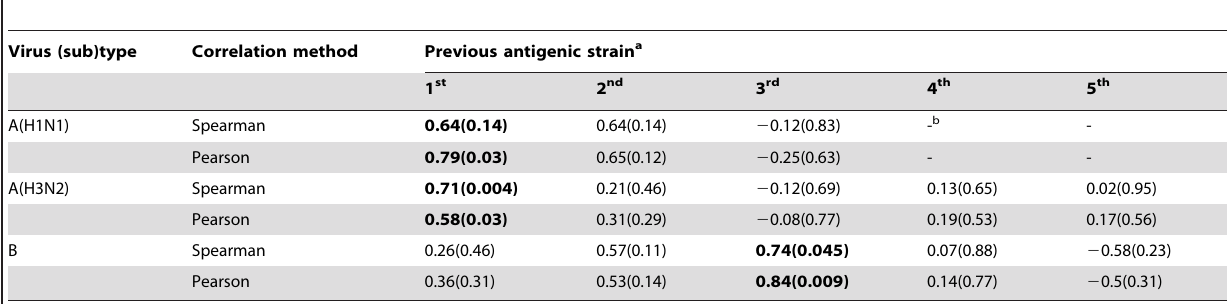
Table 1. The Spearman and Pearson Correlation Coefficients between the excess all-cause mortalities and antigenic distances to previous individual antigenic strains.